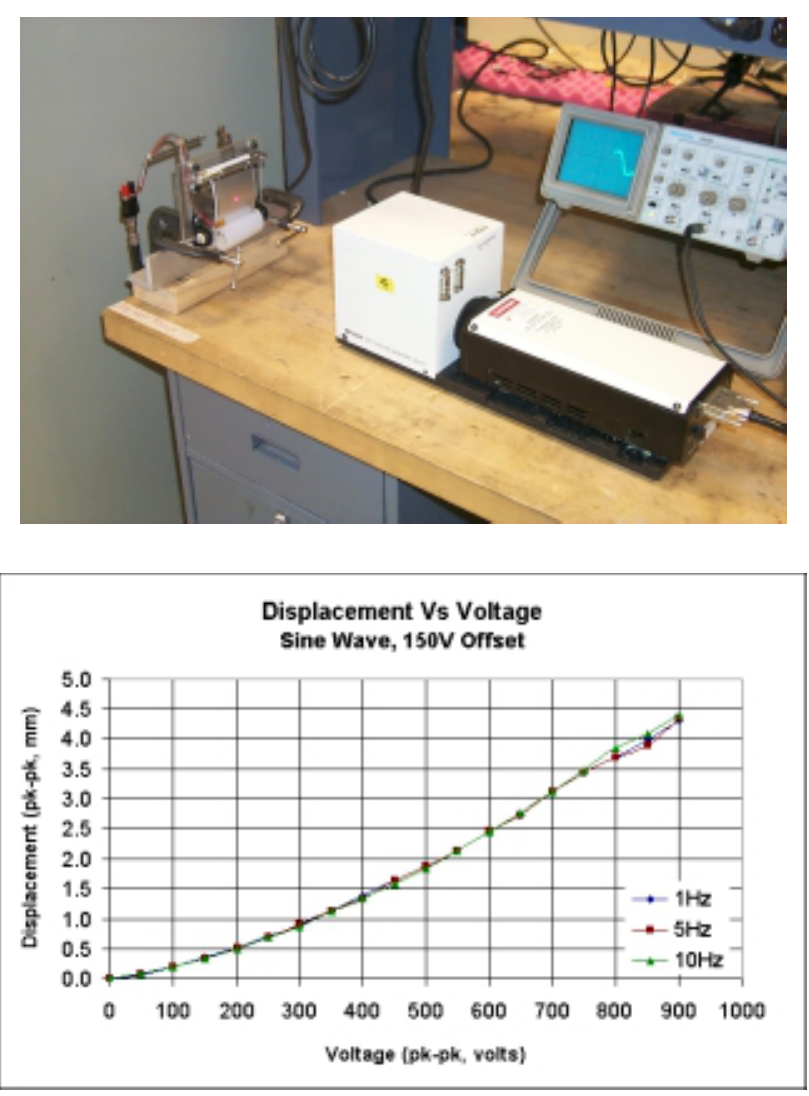
Fig. 9. Experimental setup from free displacement measurement (top) and measured actuator free displacement versus voltage